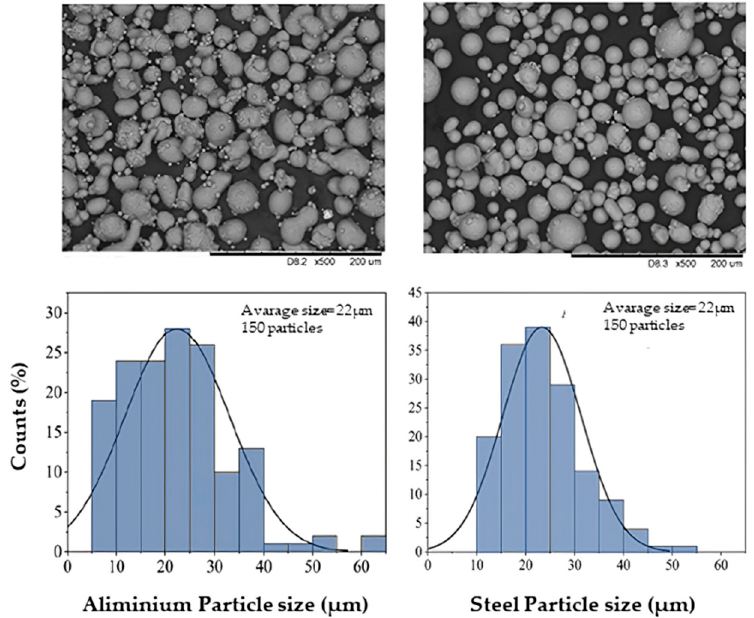
Figure 1. Exemplificative sketch of the laminates build-up sequence.